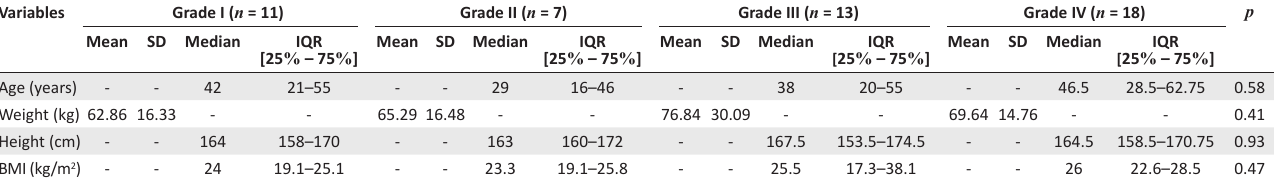
10MWT, 10-metre walk test; SD, standard deviation; SF-36 PC, short-form 36-item health survey questionnaire, physical component; SF-36 MC, short-form 36-item health survey questionnaire, mental component; WOMAC, West Ontario and McMaster osteoarthritis TABLE 4: Comparison of age and anthropometry based on grades of hip osteoarthritis. Variables